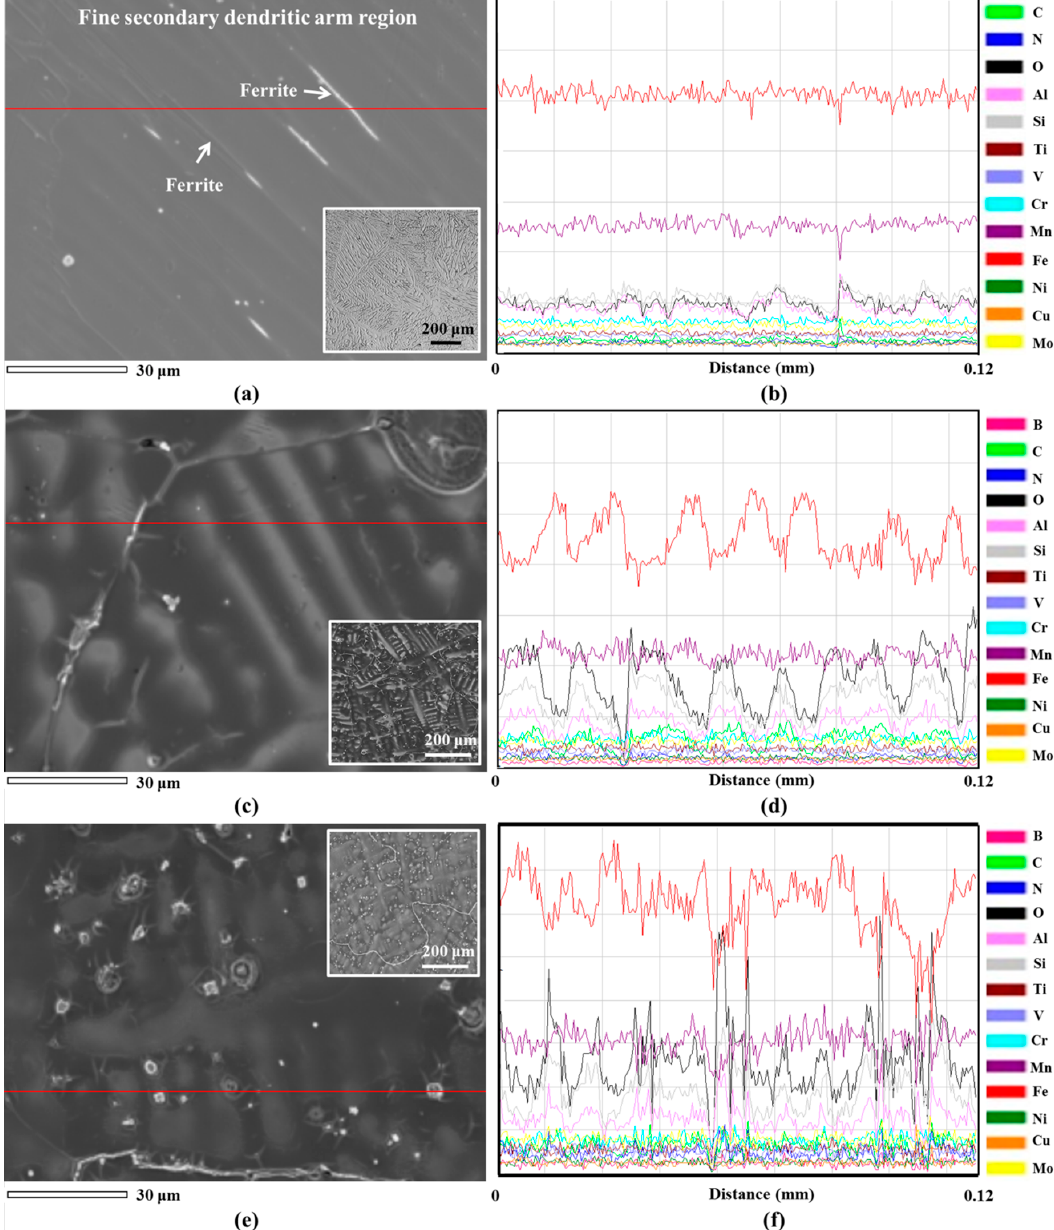
Figure 8. Solute segregation profile along solidification structure in studied low-carbon highly alloyed TWIP steel: ( a,b ) Microstructure and SEM–EDX analysis by line scanning in TW-B0; ( c,d ) microstructure and line scan SEM–EDX analysis in TW-B1; and ( e,f ) microstructure and line scan SEM–EDX analysis in TW-B2.